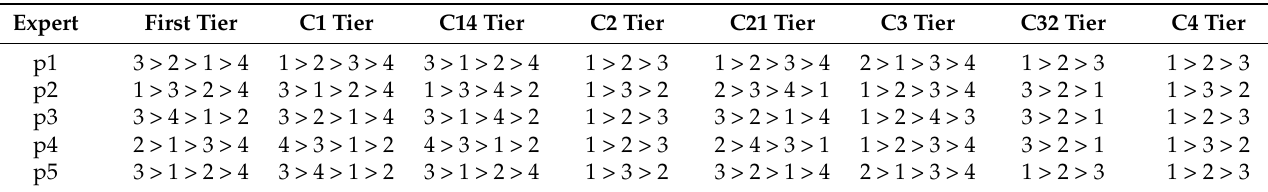
Table 4. Order relations scoring of criteria.